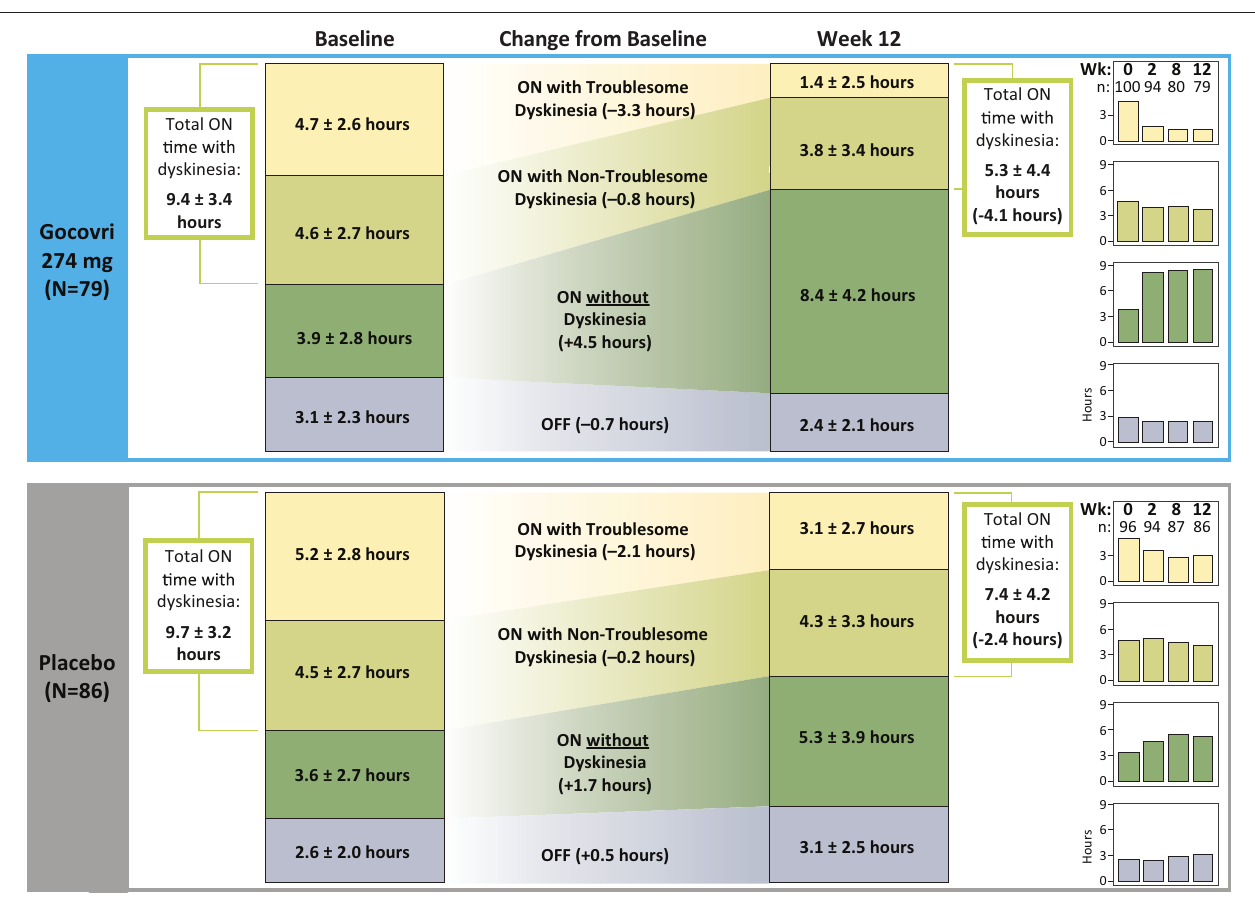
FIGURE 1 | Change from Baseline to Week 12 in time spent in the different motor diary states (numbers are absolute mean ± SD).